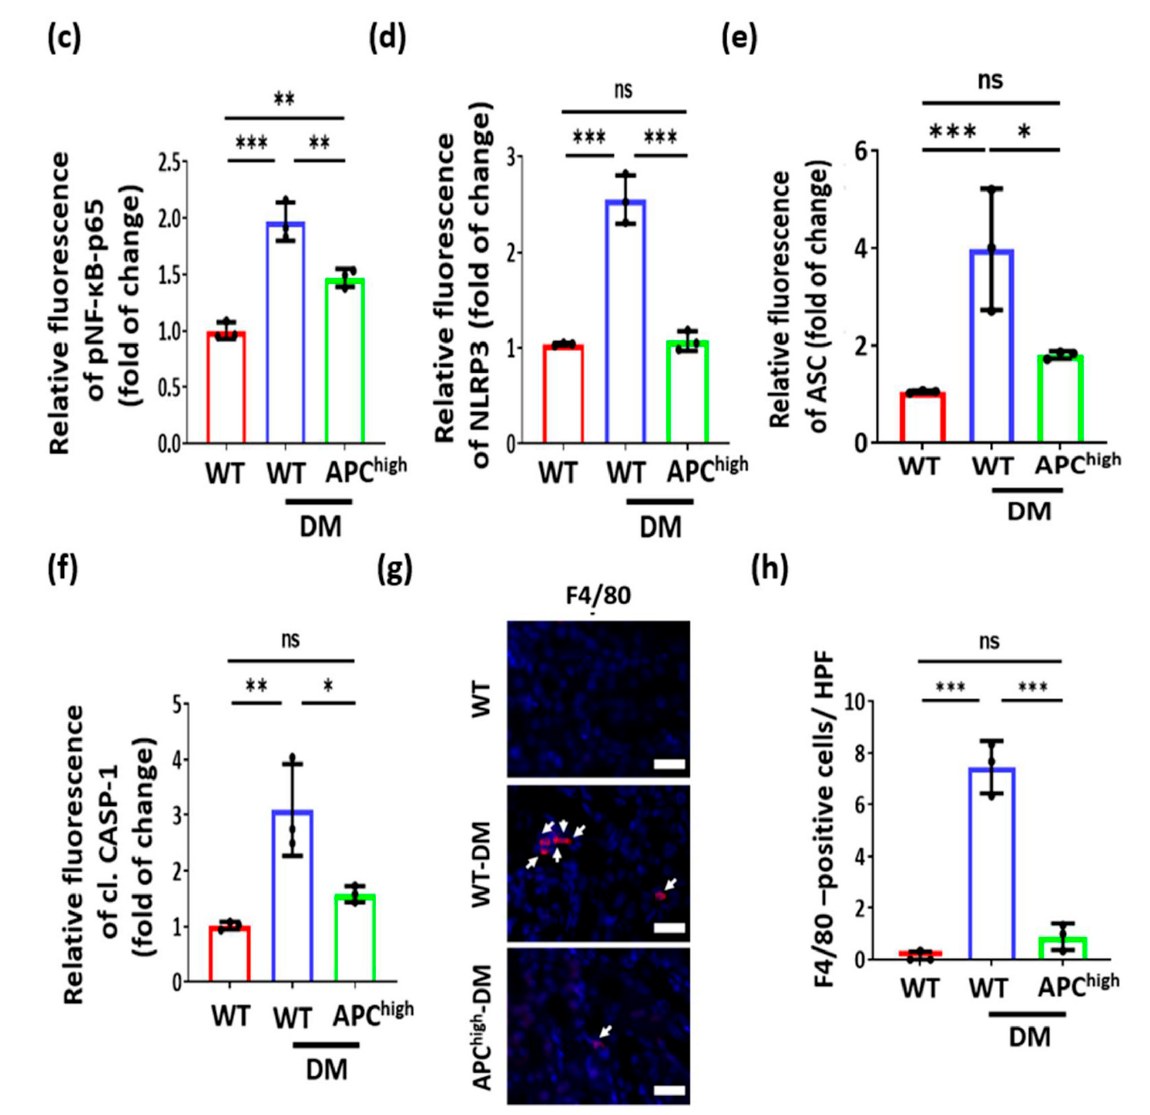
Figure 4. aPC reduces inflammasome activation in hyperglycaemia. ( a ) Bar graph with dot plot summarizing mRNA levels of p65 NF-kB, Nlrp3, Asc, and Casp1 (q-RT–PCR) in control (normal glucose, 5 mM) and high glucose (25 mM)-treated BUMPT cells without (HG) or with aPC pretreat- ment (20 nM, 1 h, HG + aPC). ( b – f ) Representative immunofluorescence images ( b ) and bar graphs with dots summarizing the results ( c – f ) of kidney sections stained for pNf-kb-p65, Nlrp3, cleaved caspase-1 or Asc (all red, DAPI nuclear counterstain, blue; groups as described in a. ( g , h ) Repre- sentative immunofluorescence images ( g ) and bar graphs summarizing the results ( h ) of kidney sections stained for macrophages (F4/80, red; DAPI nuclear counterstain, blue); arrow indicates positive staining. * p < 0.05; ** p < 0.01; *** p < 0. 001 ( a , c – f , h ). Statistical analyses were per- formed using one-way ANOVA with Sidak’s multiple comparison test. aPC = activated protein; ASC = adaptor molecule apoptosis-associated speck-like protein containing a CARD; C = control; Casp1 = Caspase- 1; DAPI = 4 (cid:48) ,6-diamidino-2-phenylindole; DM = diabetes mellitus; HG = high glucose; MFI= mean fluorescent intensity; NF- κ B = Nuclear factor kappa-light-chain-enhancer of activated B cells; NLRP3 = NLR family pyrin domain containing 3; VDAC = voltage-dependent anion channel; WT =